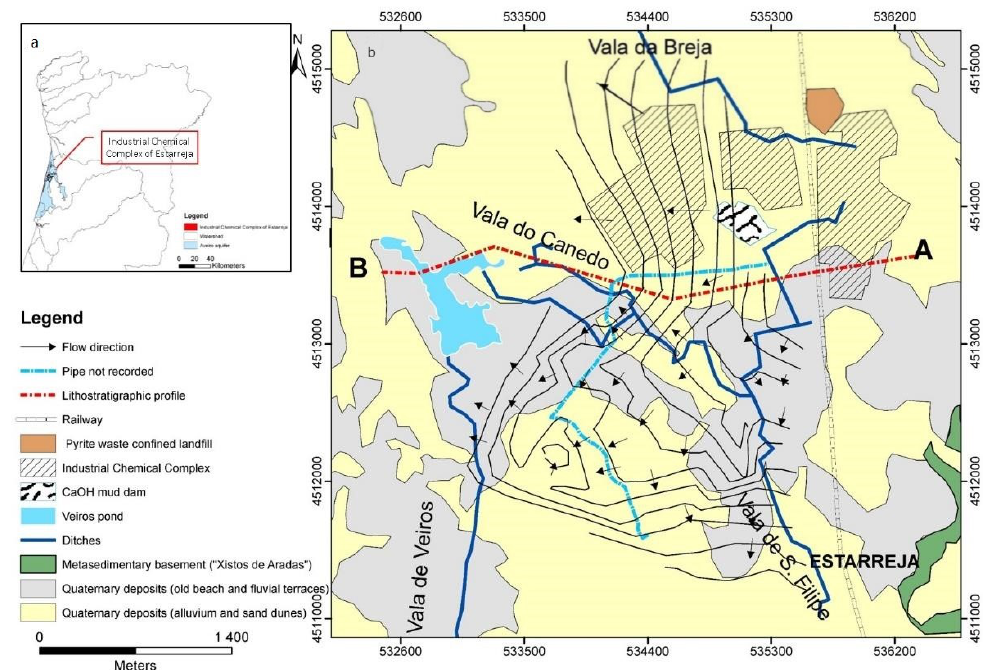
Figure 1. ( a ) Location of the Aveiro aquifer boundary and the industrial chemical complex of Estarreja, northern Portugal; ( b ) Simplified geological map of the study area (adapted from Teixeira and Zbyszewski [38]) and main groundwater flow paths (compiled data from measurements made in 2015 and from Ordens [33]); map coordinates: UTM; WGS84 — 29N zone.